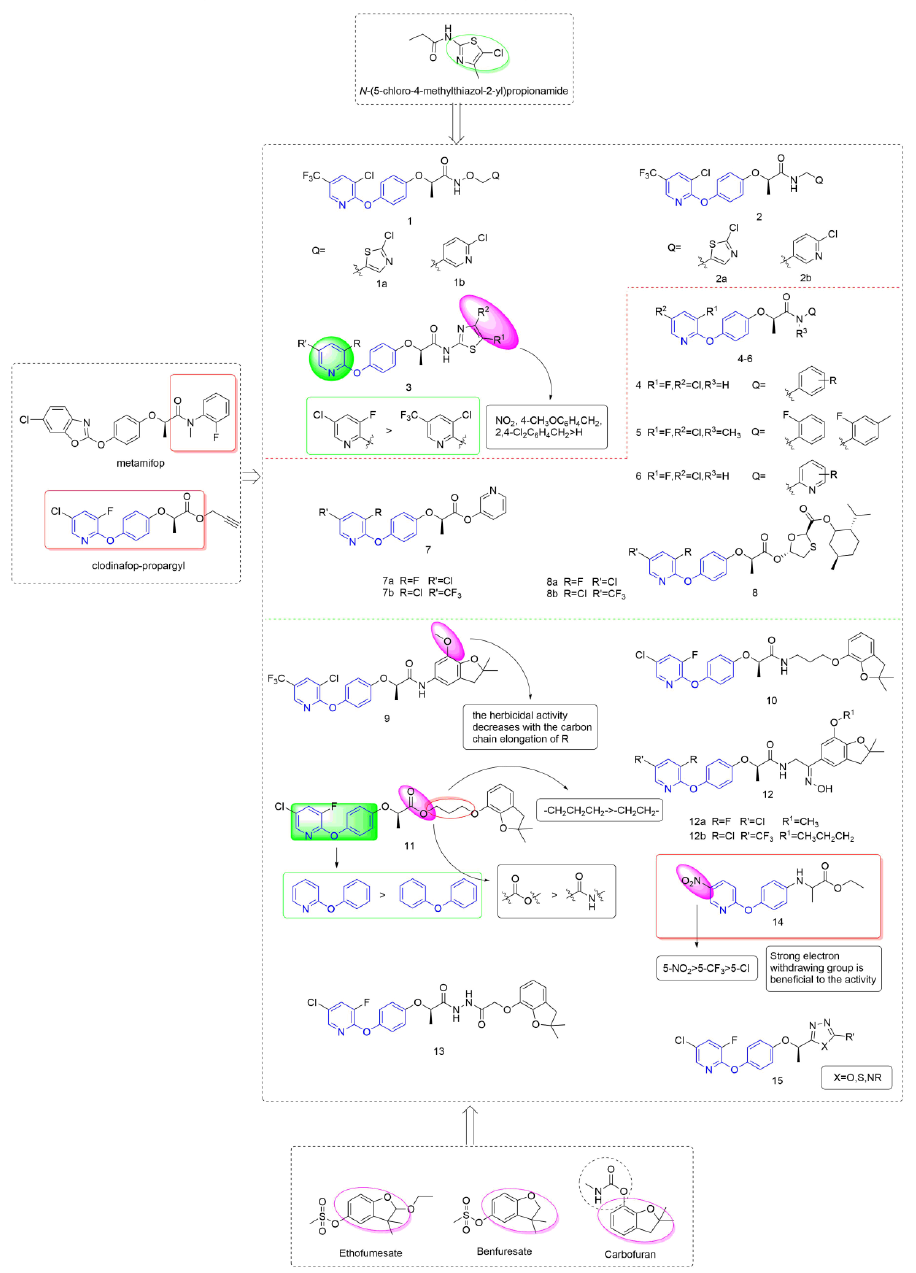
Figure 3. ACCase inhibitors containing